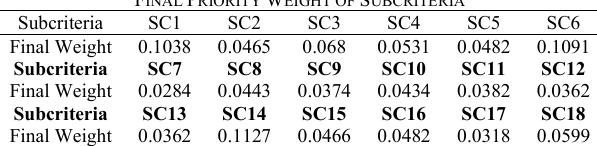
TABLE 8 F INAL P RIORITY W EIGHT OF S